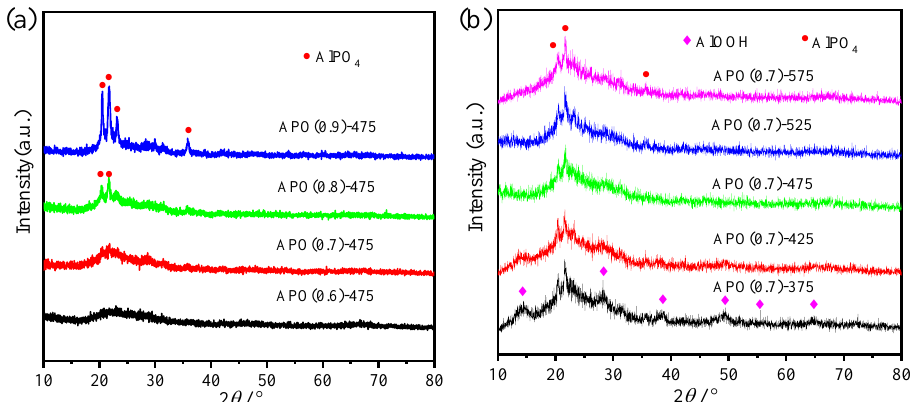
Figure 1. XRD patterns of APO catalysts with different ( a ) P/Al ratios and ( b ) calcination tempera- tures. Table 1. Physico-chemical characteristics of APO catalysts.